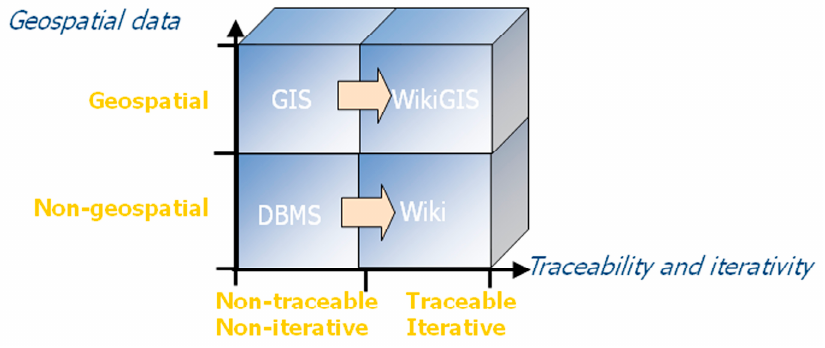
Figure 2. Utility of